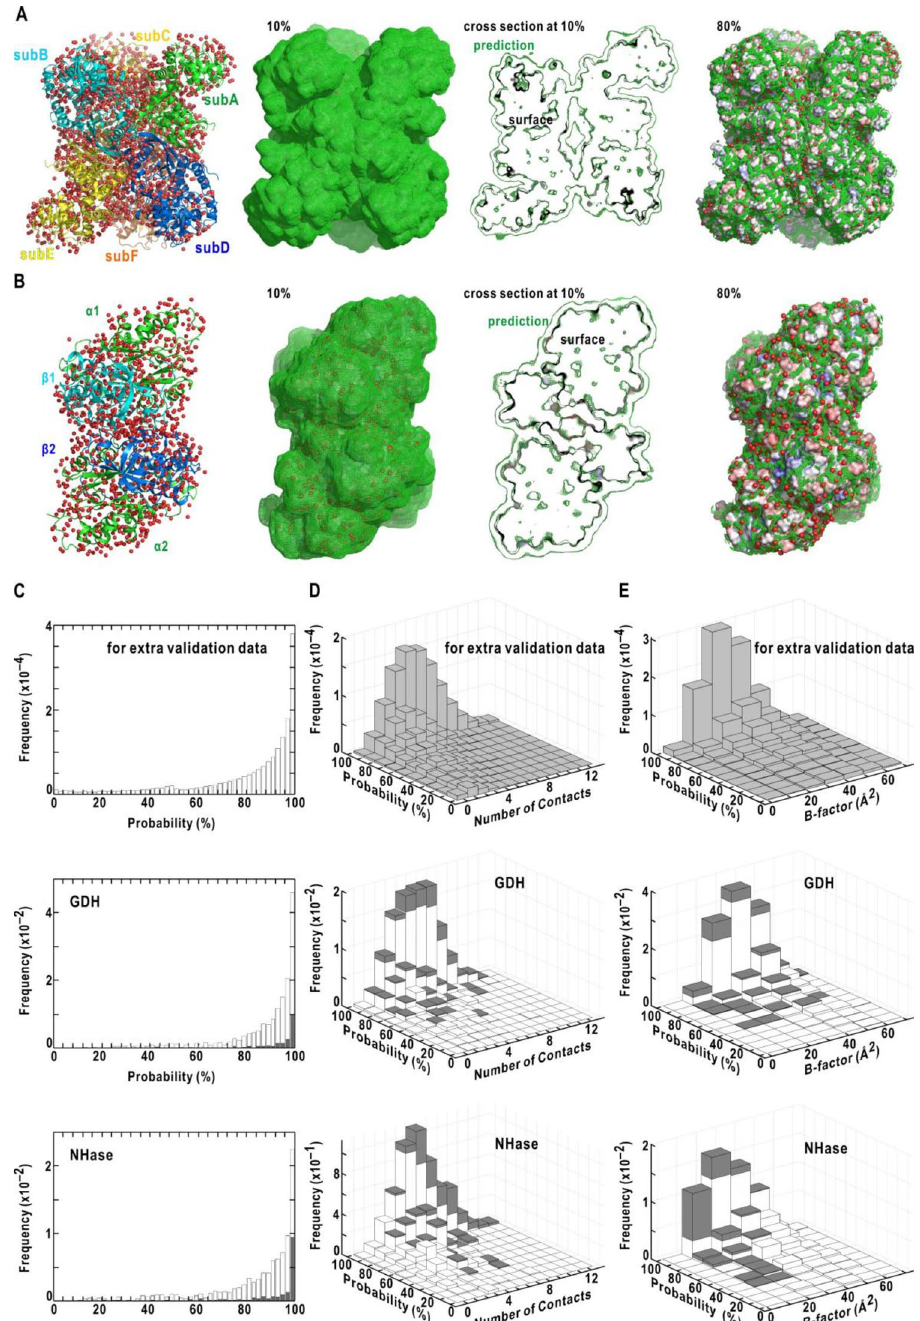
Figure 2. Characteristics of the predicted hydration probability distributions on protein surfaces. ( A ) The predicted hydration distribution for the crystal structures of GDH composed of six subunits (the accession code of PDB: 1euz). ( B ) The predicted hydration distribution for NHase composed of two α-subunits and two β-subunits (the accession code of PDB: 2ahj). The crystal structures of two protein molecules are depicted as ribbon models in the left panels (SI Appendix, Table S2). The probability distributions contoured at 10%, and 80% levels are displayed on the surface-rendered models of the crystal structures. The middle panel is the cross- sectional view of the 10% probability at the plane of the molecular center. Red spheres of 2 Å diameter indicate the locations of crystal-water sites. ( C ) The frequency distributions of the predicted probabilities at crystal-water sites. ( D ) The correlation between the probability and the number of interactions. ( E ) The correlation between the probability and the thermal factors of water molecules. In panels ( C ) – ( E ), plot shown are for the 300 protein structures for validation (upper panel), GDH (middle) and NHase (lower). For GDH and NHase, the hydration sites in the first-layer and inside classes are shown using white and gray bars, respectively, and the frequencies of the two classes were stacked in panels ( D ) and ( E ). All molecular images were drawn using PyMOL 60